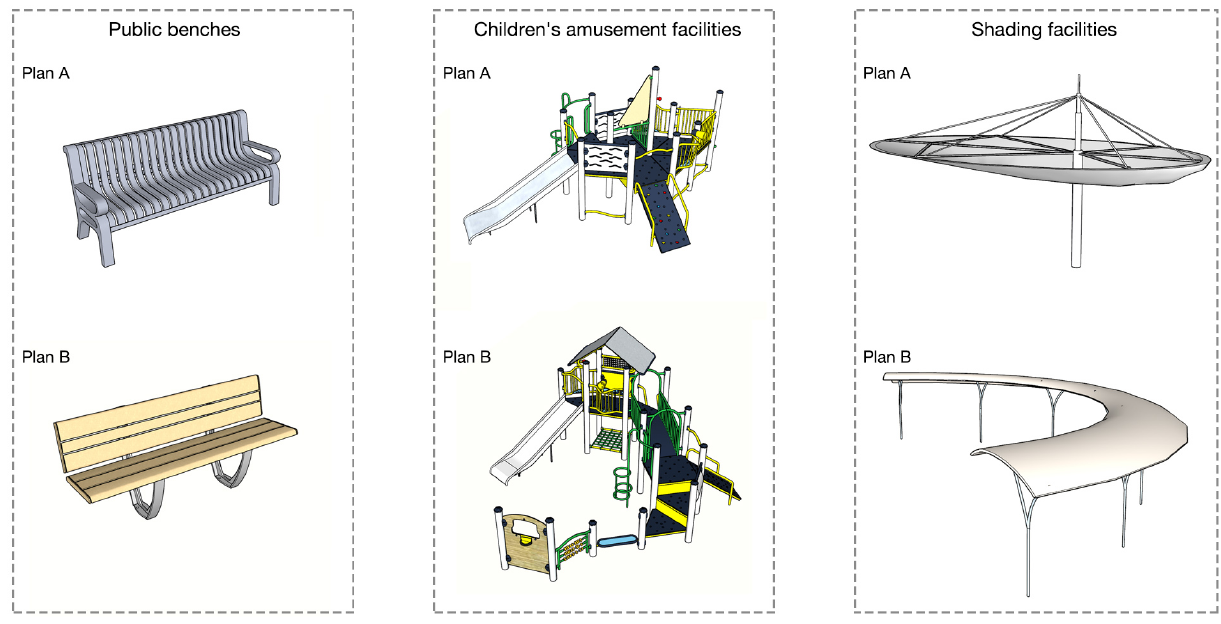
Figure 5. Examples of designed works in the